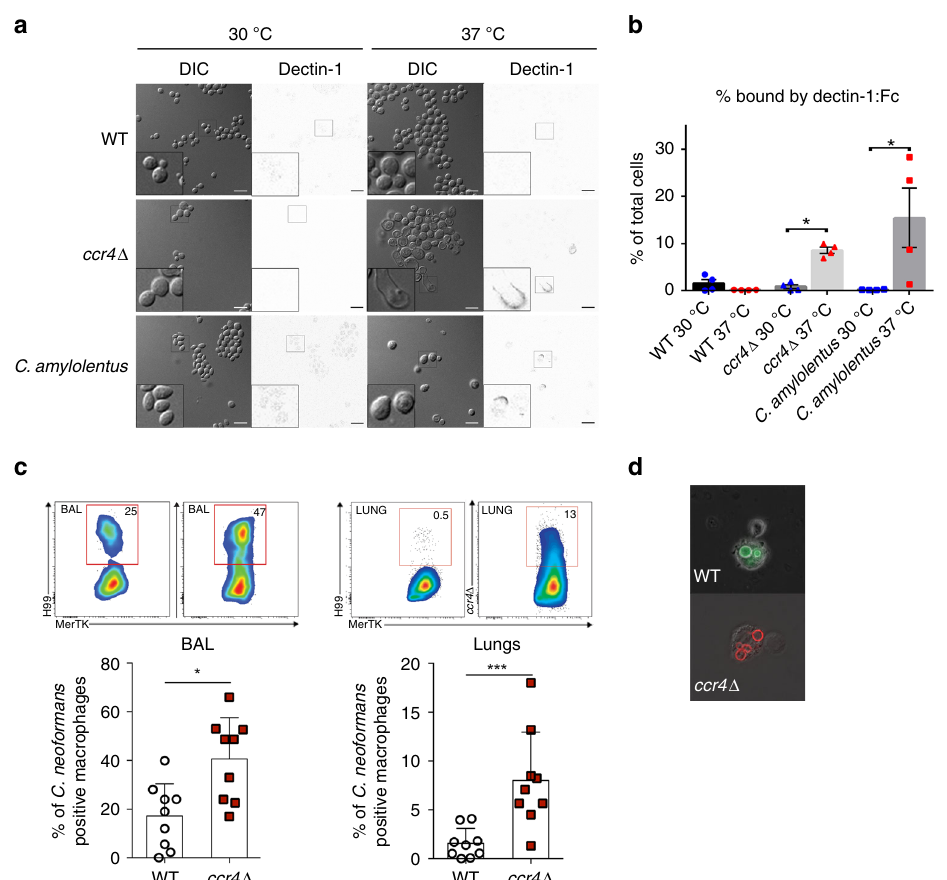
Fig. 6 Glucan exposure results in Dectin-1 recognition and phagocytosis. a Wild-type C. neoformans , the ccr4 Δ mutant, and wild-type C. amylolentus were grown at 30°C or 37°C and incubated with mouse Dectin-1-human-Fc protein conjugate followed by fl uorescent labeling and microscopy. Scale bar = 10 µ m. Insets show magni fi ed views of cells outlined in boxes. b Recognition of cells by Dectin-1 was measured by fl ow cytometry. Graph depicts the mean percentage of cells±s.e.m. ( n = 4) bound by mouse Dectin-1:human-Fc conjugate, and signi fi cance was determined by Kruskal – Wallis and Dunn ’ s test post hoc. c BalbC/J mice were infected intranasally with 2.5×10 6 Alexa fl uor-488-labeled WT cells or Alexa fl uor-594 labeled ccr4 Δ cells for 5h. BAL and digested lung were analyzed by fl ow cytometry for macrophages associated with C. neoformans . Graphs show the mean percentage of macrophages containing cryptococci±SD ( n = 3), and signi fi cance was determined by Wilcoxen – Mann U test. Gating strategy is demonstrated in Supplementary Fig. 6. d Fluorescence microscopy images from BAL samples showing WT (green) or ccr4 Δ (red) cells inside phagocytes. Source data are provided as a Source Data fi le